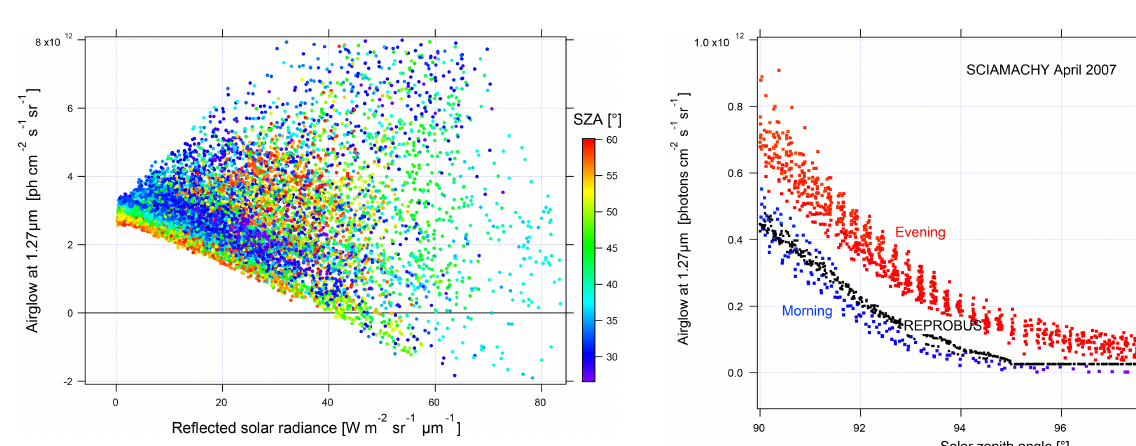
Figure 19. Airglow nadir intensity versus SZA for SZA > 90 ◦ ; SCIAMACHY measurements are in red during the evening and in blue during the morning; REPROBUS v02 simulations are in black. The observed difference between morning and evening values is due to the long lifetime of O 2 (a 1 (cid:49) g ).